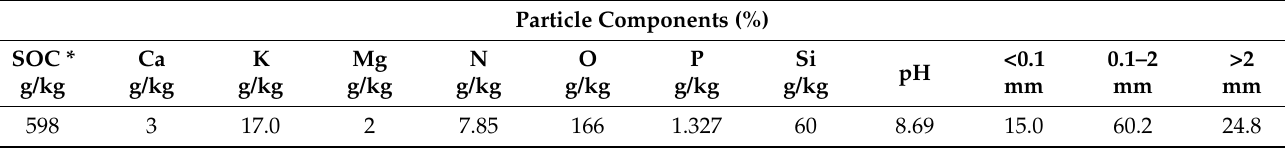
Table 2. Particle components of the